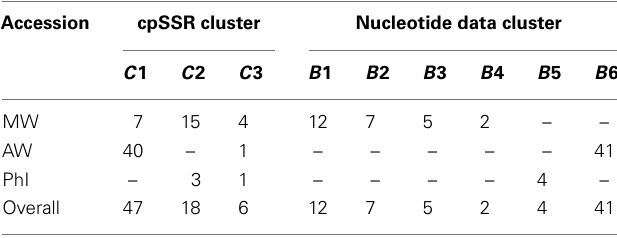
Table 6 | Distribution of the 71 accessions shared between nucleotide and cpSSR data into the six nucleotide data clusters ( B 1, B 2, B 3, B 4, B 5, and B 6) and the four cpSSR clusters ( C 1, C 2, C 3, C 4) identified by the BAPS